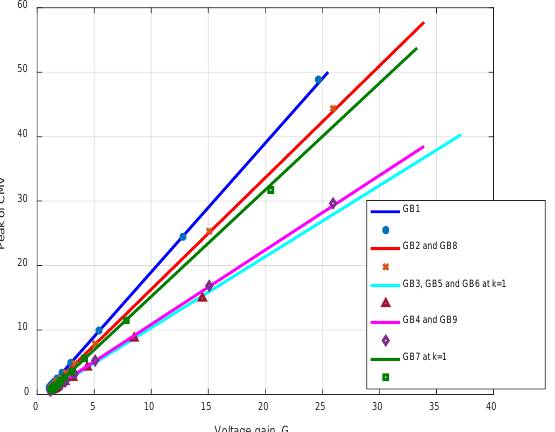
Figure 24. The normalized Peak CMV Versus G . Solid lines: theoretical results, marks: simulation results.